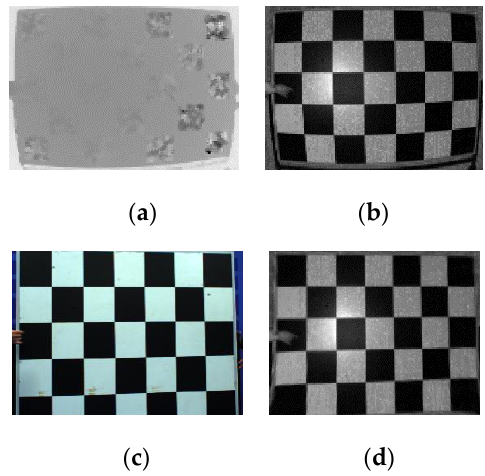
Figure 6. Depth map problems captured by ToF depth sensors. ( a ) Distance map, ( b ) amplitude map, ( c ) color image, and ( d ) corrected amplitude map.